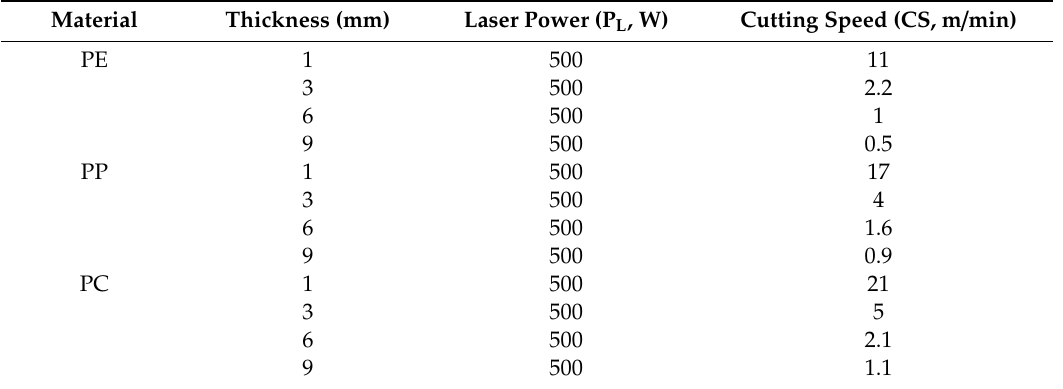
Table 1. Cutting parameter levels for polyethylene (PE), polypropylene (PP), and polycarbonate (PC) in the fusion cutting mechanism [22].